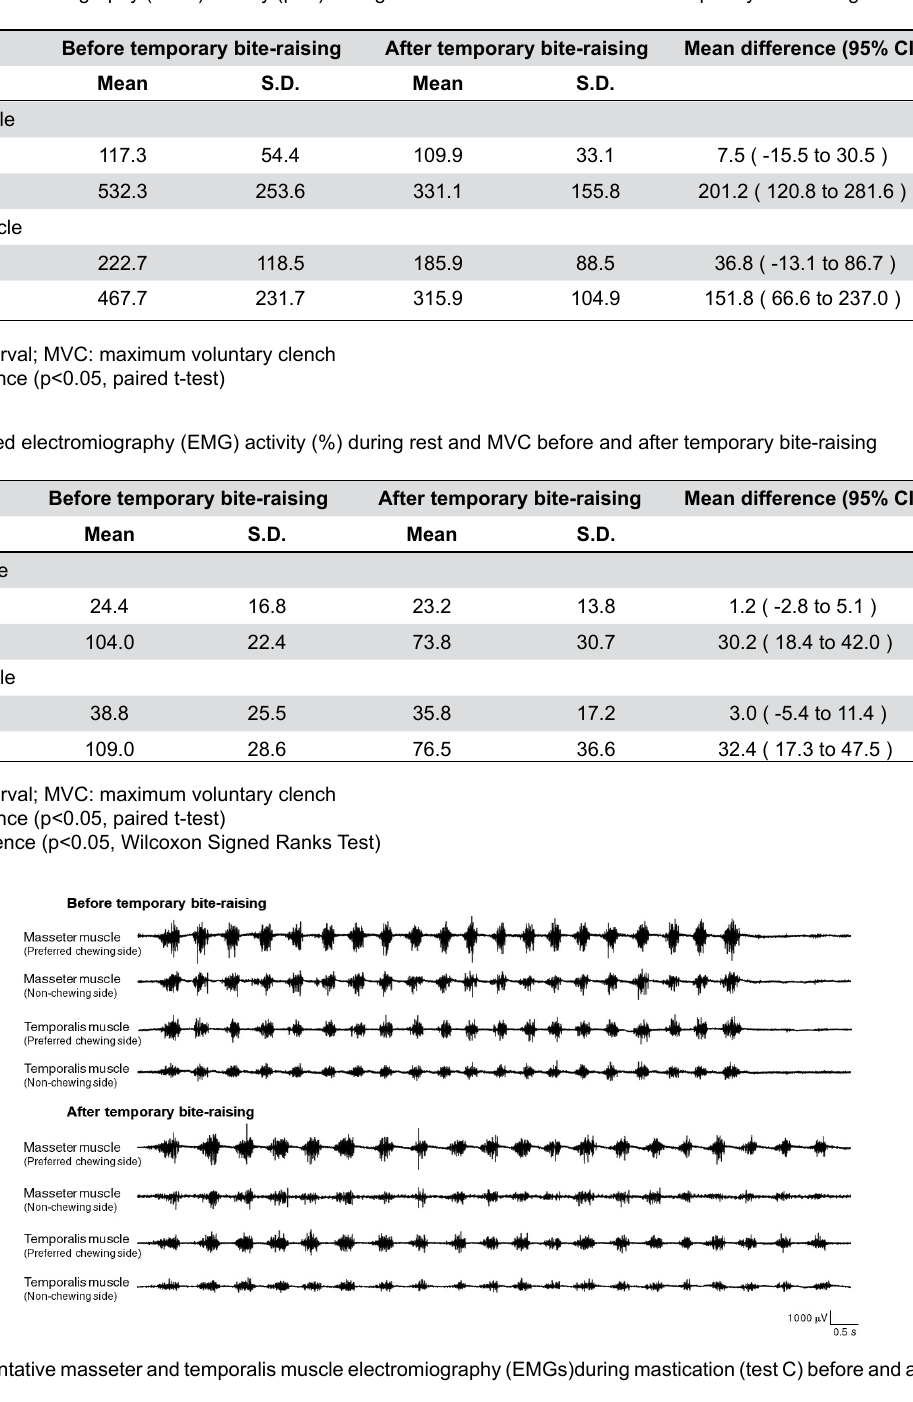
Table 1- Integral electromiography (EMG) activity (μVs) during rest and MVC before and after temporary bite-raising